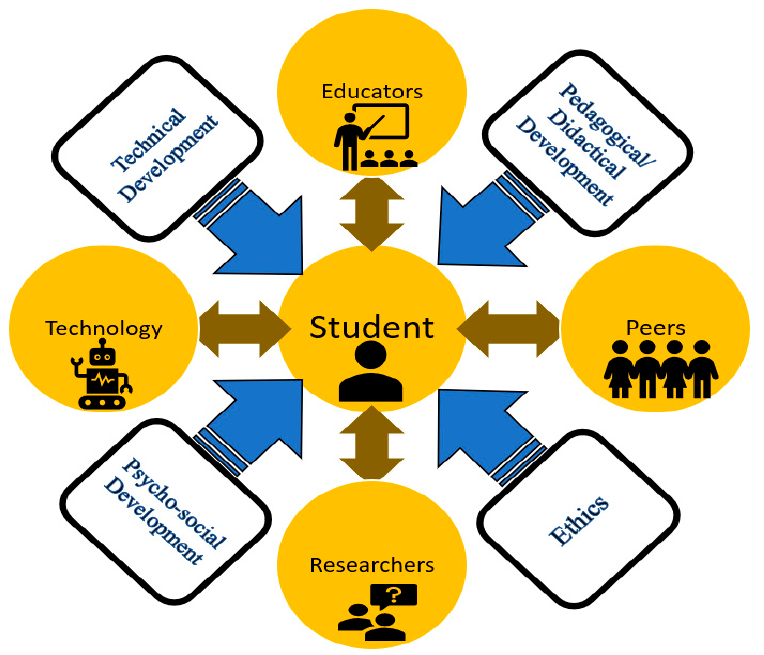
Figure 1. A framework for introducing humanoid robots in school learning environments.